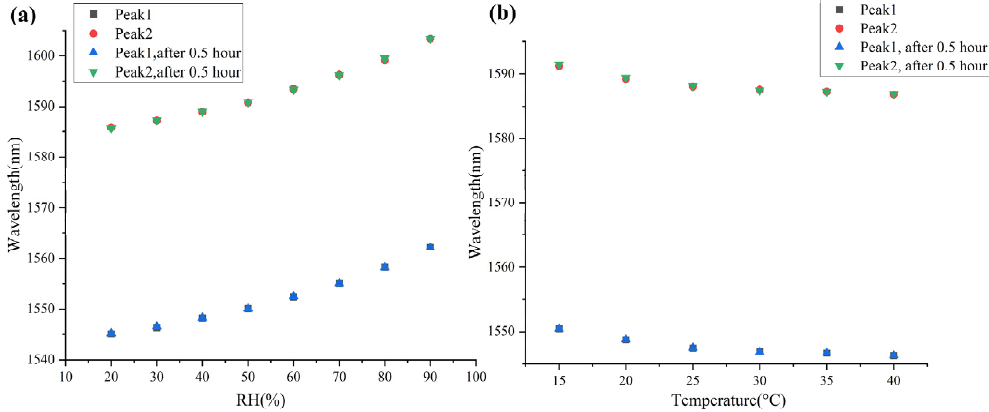
Figure 7. ( a , b ) Repeatability test of the sensor in this paper.